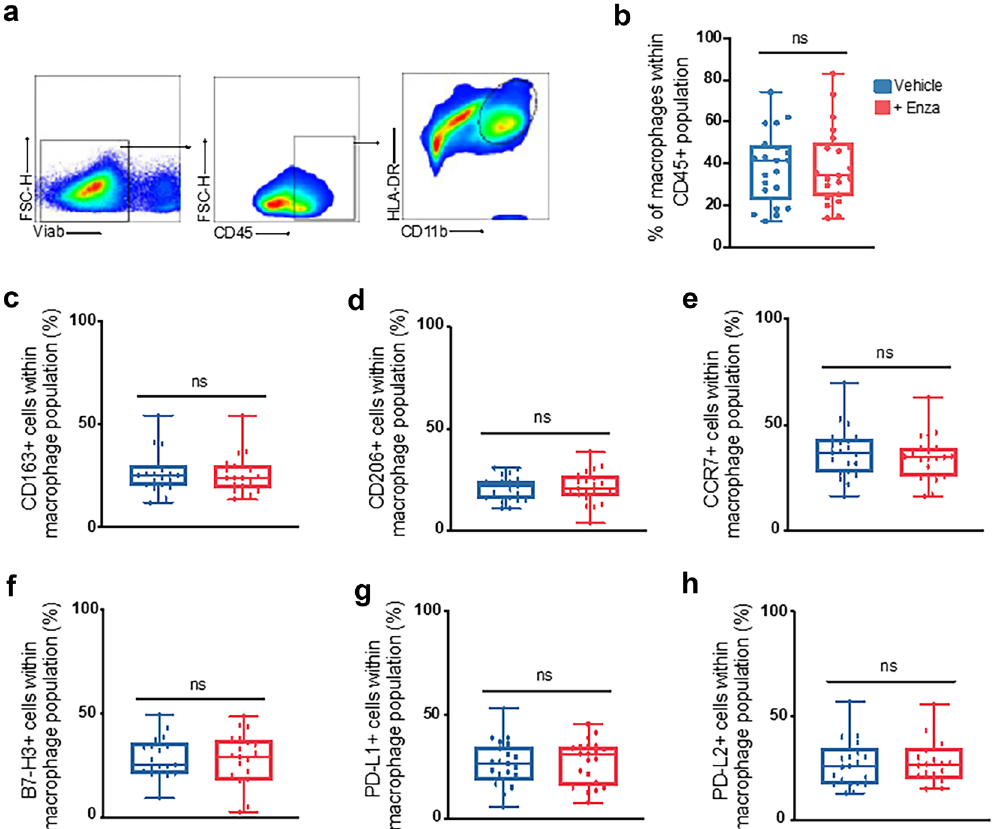
Figure 3. Enzalutamide treatment of ex vivo cultured prostate cancer biopsies induces no change in global macrophage phenotype. Gating strategy to evaluate macrophage population within CD45 + immune population ( a ). Evaluation of macrophage proportion between treated and control-treated paired samples ( b ). M1-associated marker (CCR7), M2-associated marker (CD163, CD206) and immune checkpoints (B7-H3, PD-L1, and PD-L2) between treated and control-treated paired-samples ( c – h ). n = 21, paired and non-paired Student’s T-test, ns = statistically not